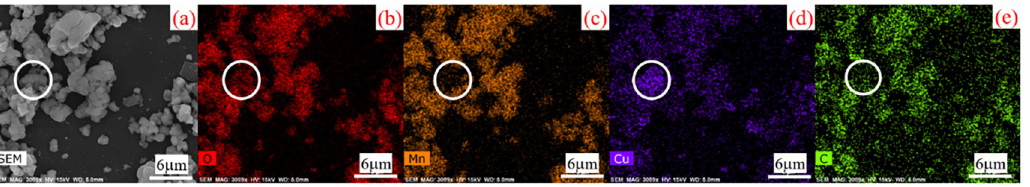
Fig 2. SEM image (a) and O (b), Mn (C), Cu (d) and C (e) elements mapping of the fabricated MCE